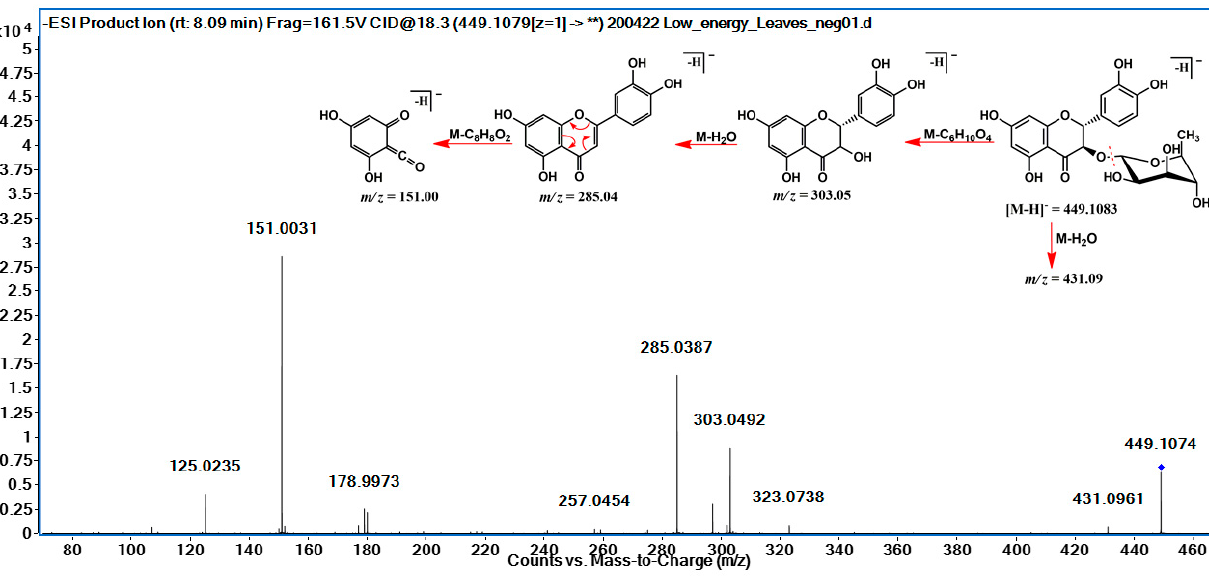
Figure 3. Proposed fragmentation mechanism of flavonoid O -glycoside astilbin ( 16 ). 30